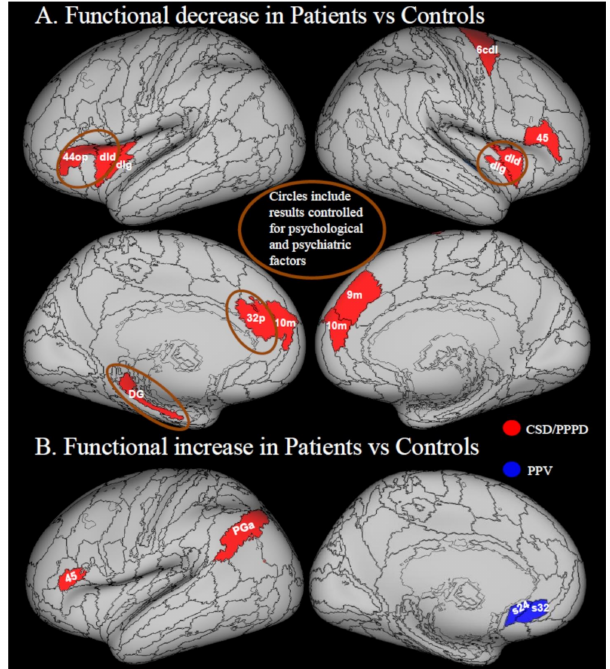
Figure 3. Functional response in Patients vs. Controls. Regions from PPPD are in red, regions from PPV are in blue. ( A ) Functional parameter reduction. Indovina et al. [39] found decreased response to sound-evoked vestibular stimulation in the left hippocampus (dentate gyrus = DG), left inferior frontal gyrus (opercular BA 44 = 44 op)/anterior insula, right posterior insula (dorsal granular insula = dIg) and left pregenual cingulate cortex (32 p). Riccelli et al. [49] found decreased response to vertical vs. horizontal visual motion in right middle insula (dId). Na et al. [45] found decreased response during rest in right BA 45, right BA 6 cdl, left dIg, bilateral BA10 m, left FO2 (not visible), right BA 9m. ( B ) Functional parameters increase. Popp et al. [48] found increased response in the subgenual cingulate cortex (s24, s32) in patients with PPV both during visual motion stimulation and motion aftereffect. von Söhsten Lins et al. [54] found increased response in the left PGa angular gyrus in patients with PPPD in response to negative vs. positive pictures. Passamonti et al. [47] considered the effect of neuroticism after matching the control group for neuroticism and found increased response in neurotic patients in response to vertical vs. horizontal stimulation in left BA45. Regions from the Anatomy atlas [52] and Brainnetome atlas [53] are overlapped onto the Conte69 inflated brain in workbench viewer